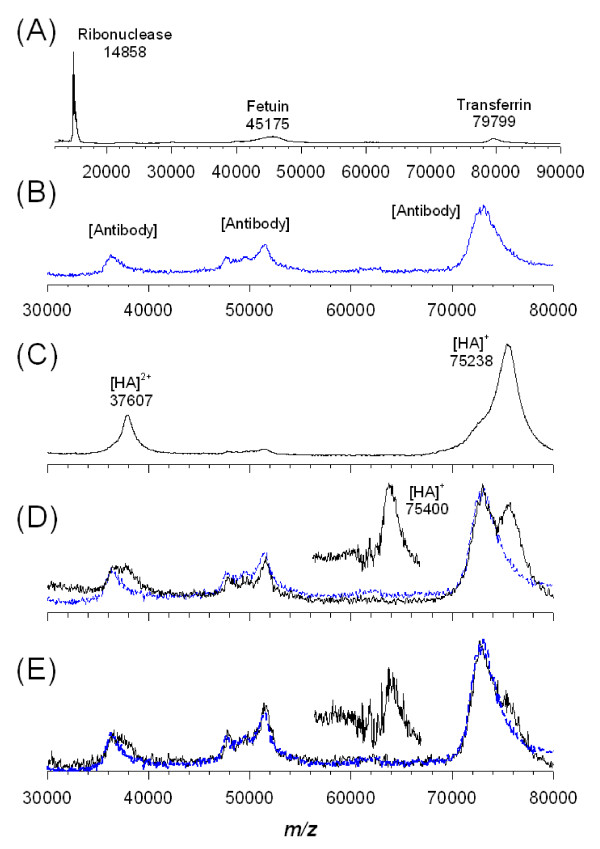
Detection sensitivity of HA protein (H5 type) after extraction by AbH5N2@Fe3O4 MNP. MALDI mass spectra of (A) protein solution (60 μL) containing HA (200 ng), ribonuclease (1 mg), fetuin (5 mg) and transferrin (5 mg); (B) background peaks from antibody; (C) extraction by AbH5N2@Fe3O4 MNP (HA signals at approximate 75 kDa and 37 kDa, corresponding to singly and doubly charged ions); (D) extraction from a protein solution (60 μL) containing HA (100 ng), ribonuclease (1 mg), fetuin (5 mg) and transferrin (5 mg) by AbH5N2@Fe3O4 MNP; and (E) extraction from a protein solution (60 μL) containing HA (50 ng), ribonuclease (1 mg), fetuin (5 mg) and transferrin (5 mg) by AbH5N2@Fe3O4 MNP. The arrow indicates the experimental m/z of HA. The blue dotted line indicates the antibody. The HA signals after subtraction of the antibody signals are shown in the insets of (D) and (E).